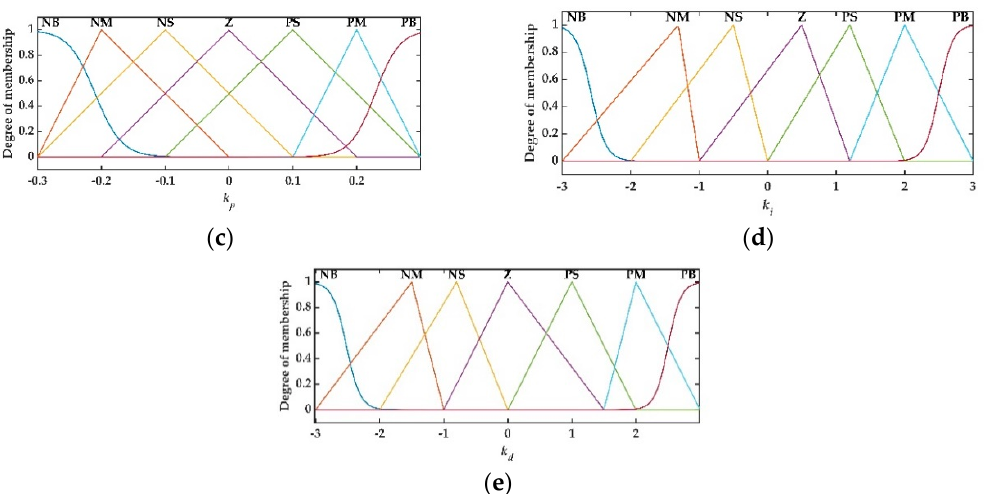
Figure 5. ( a ) Membership function e ; ( b ) membership function ec ; ( c ) membership function k p ; ( d ) membership function k i ; and ( e ) membership function k d .